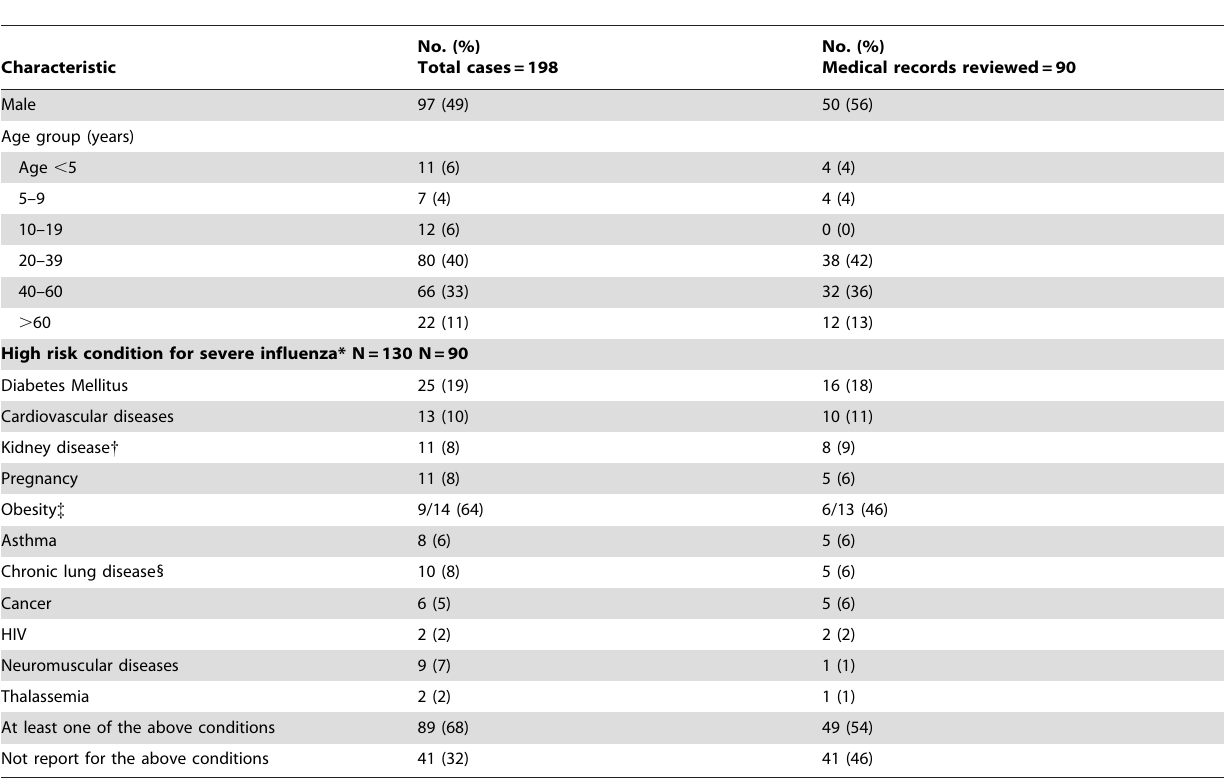
Table 1. Demographic characteristics and underlying medical conditions of influenza A (H1N1)pdm09 virus-associated